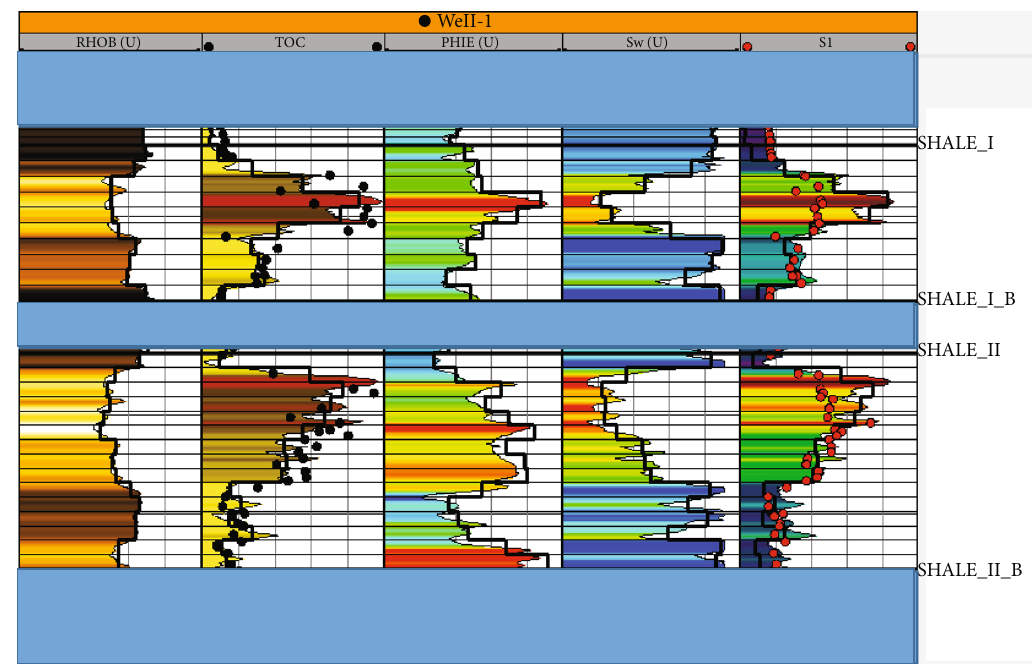
Figure 2: Petrophysical and geochemical characteristics of Lower Paleozoic shale intervals in the Polish part of the Baltic Basin — property variation observed in laboratory data, well log interpretation, and 3D model. Accordingly: rock density, TOC, e ff ective porosity, water saturation, and S 1 parameter.